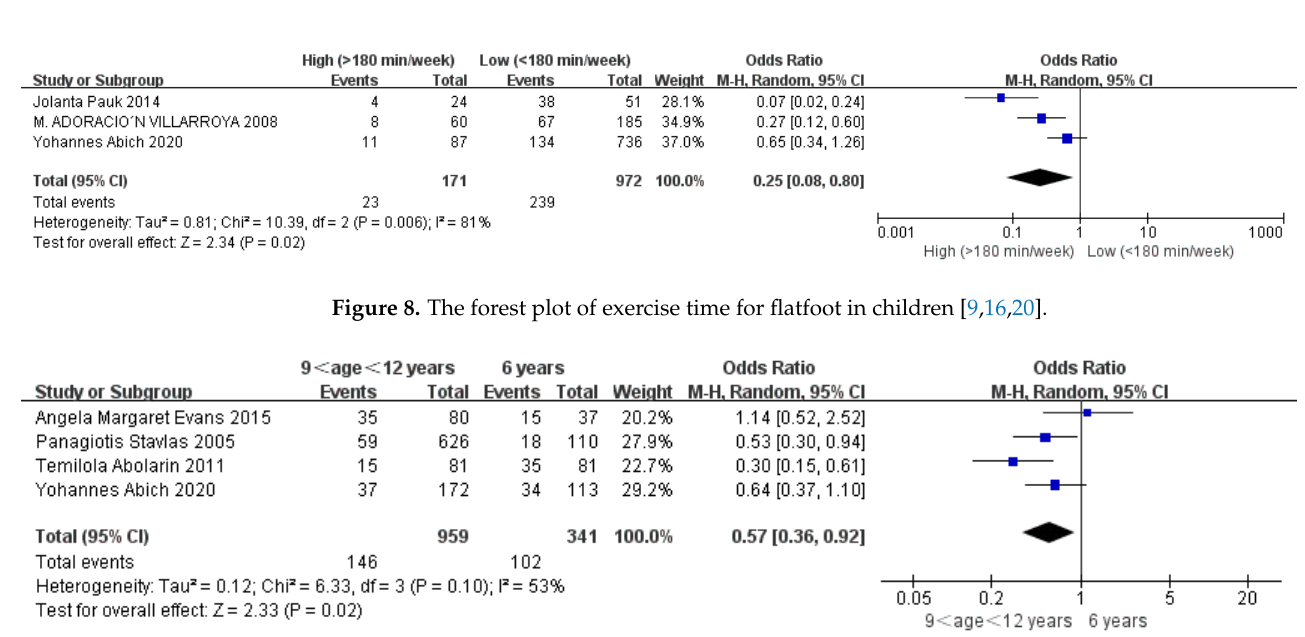
Figure 7. The forest plot of the region for flatfoot in children [11,17].